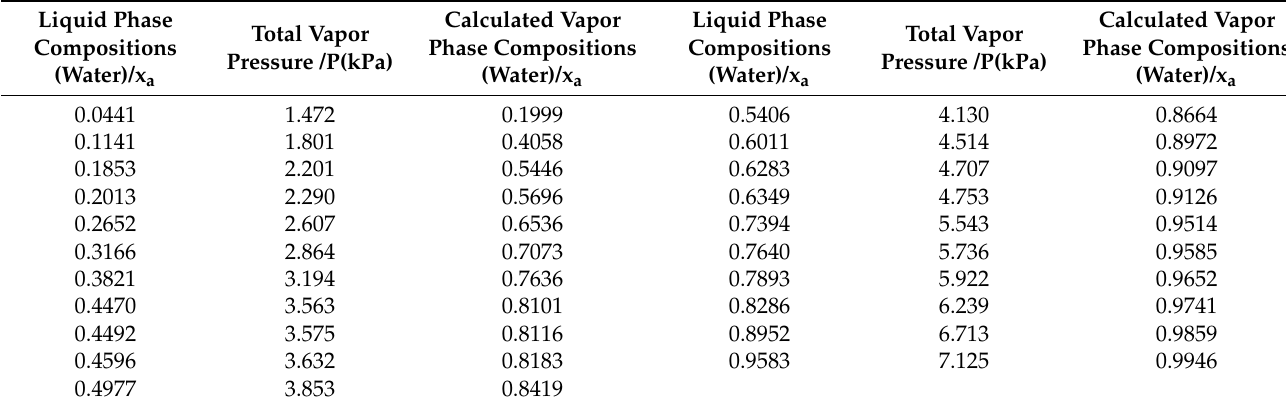
Table 1. Total vapor pressure measurements of DMF + water. Reprinted with permission from ref. [25]. Copyright 1990